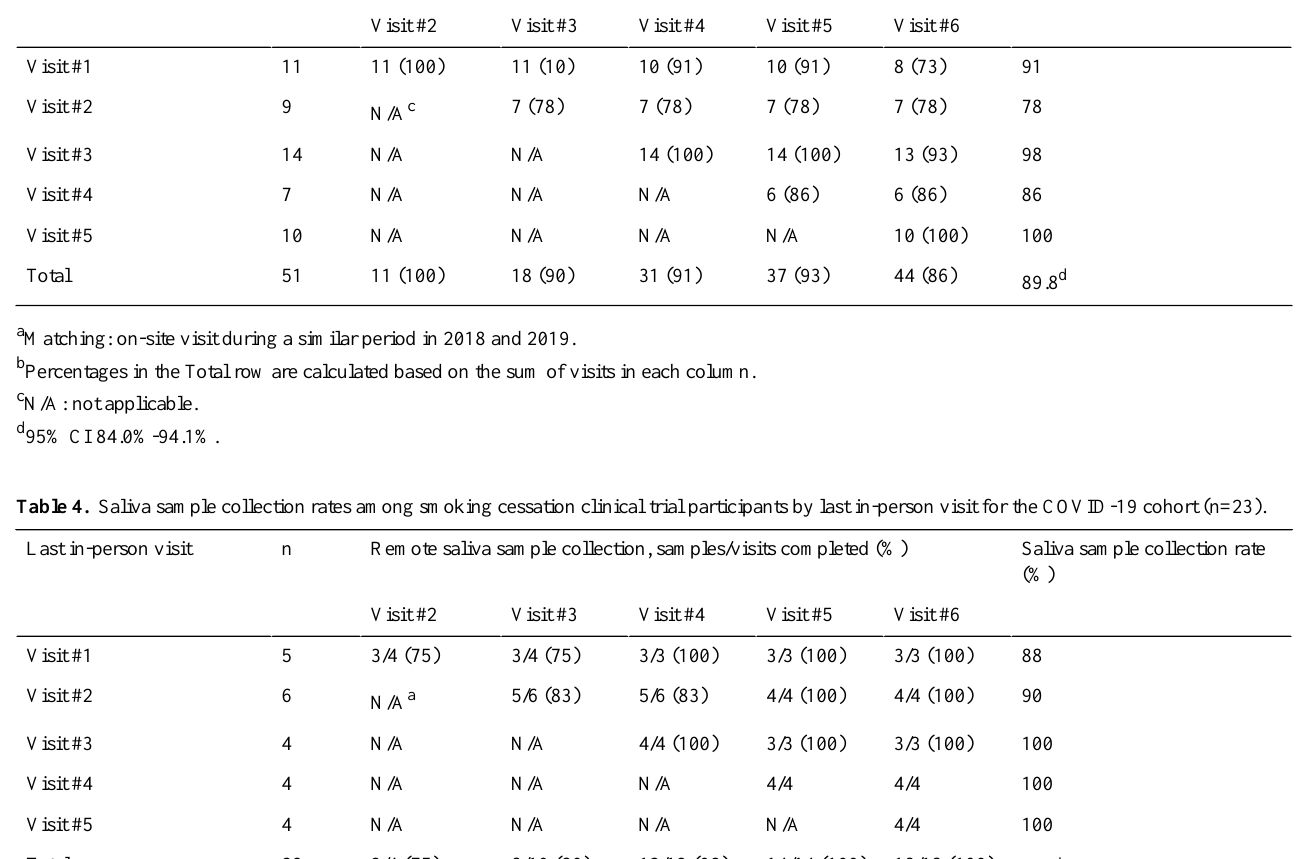
Remote visit attendance (%)Remote clinic visit completion, n (%) a nLast in-person visit